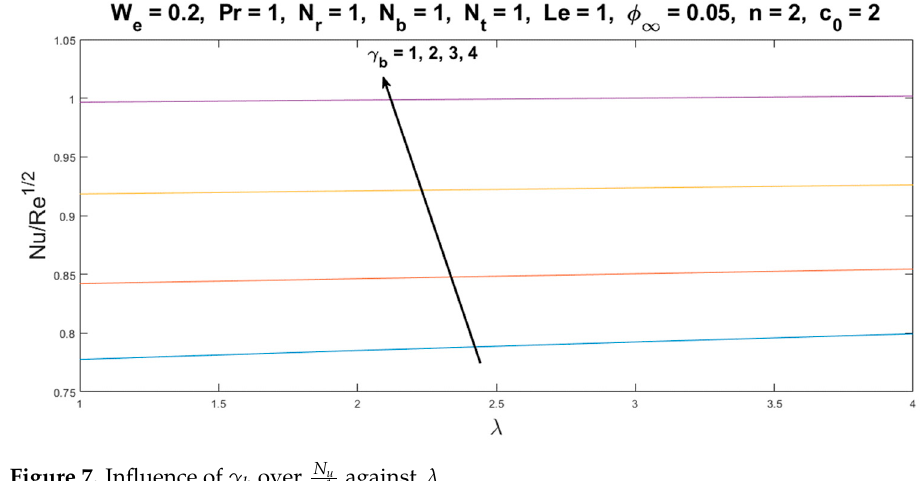
against λ . 1 2 e R